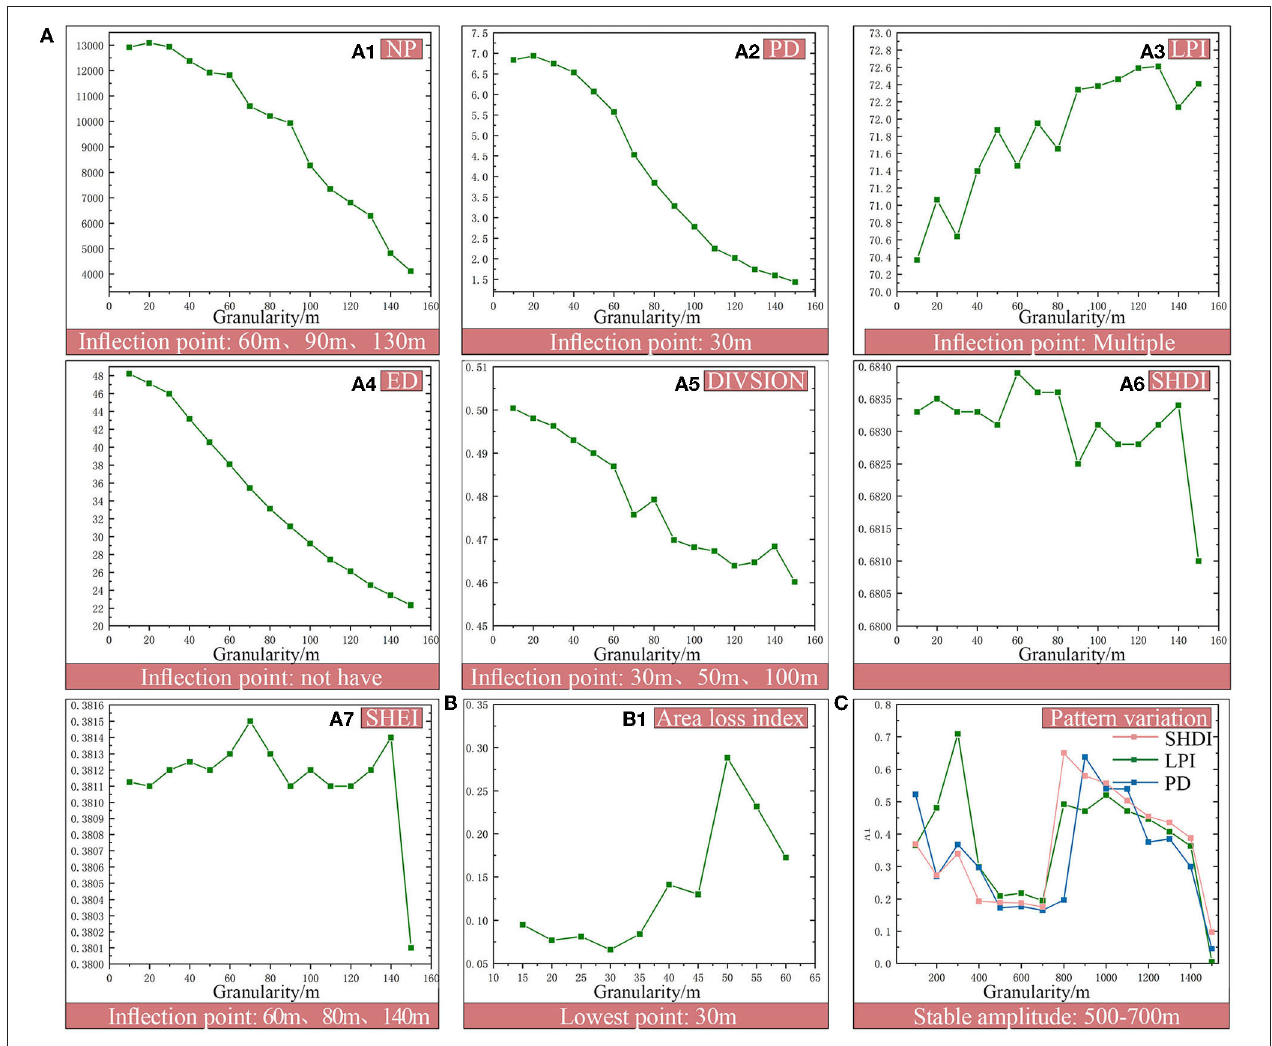
FIGURE 4 | Landscape pattern index (A) and area loss index (B) spatial variation eigenvalues and trends of landscape pattern index under different extent (C)